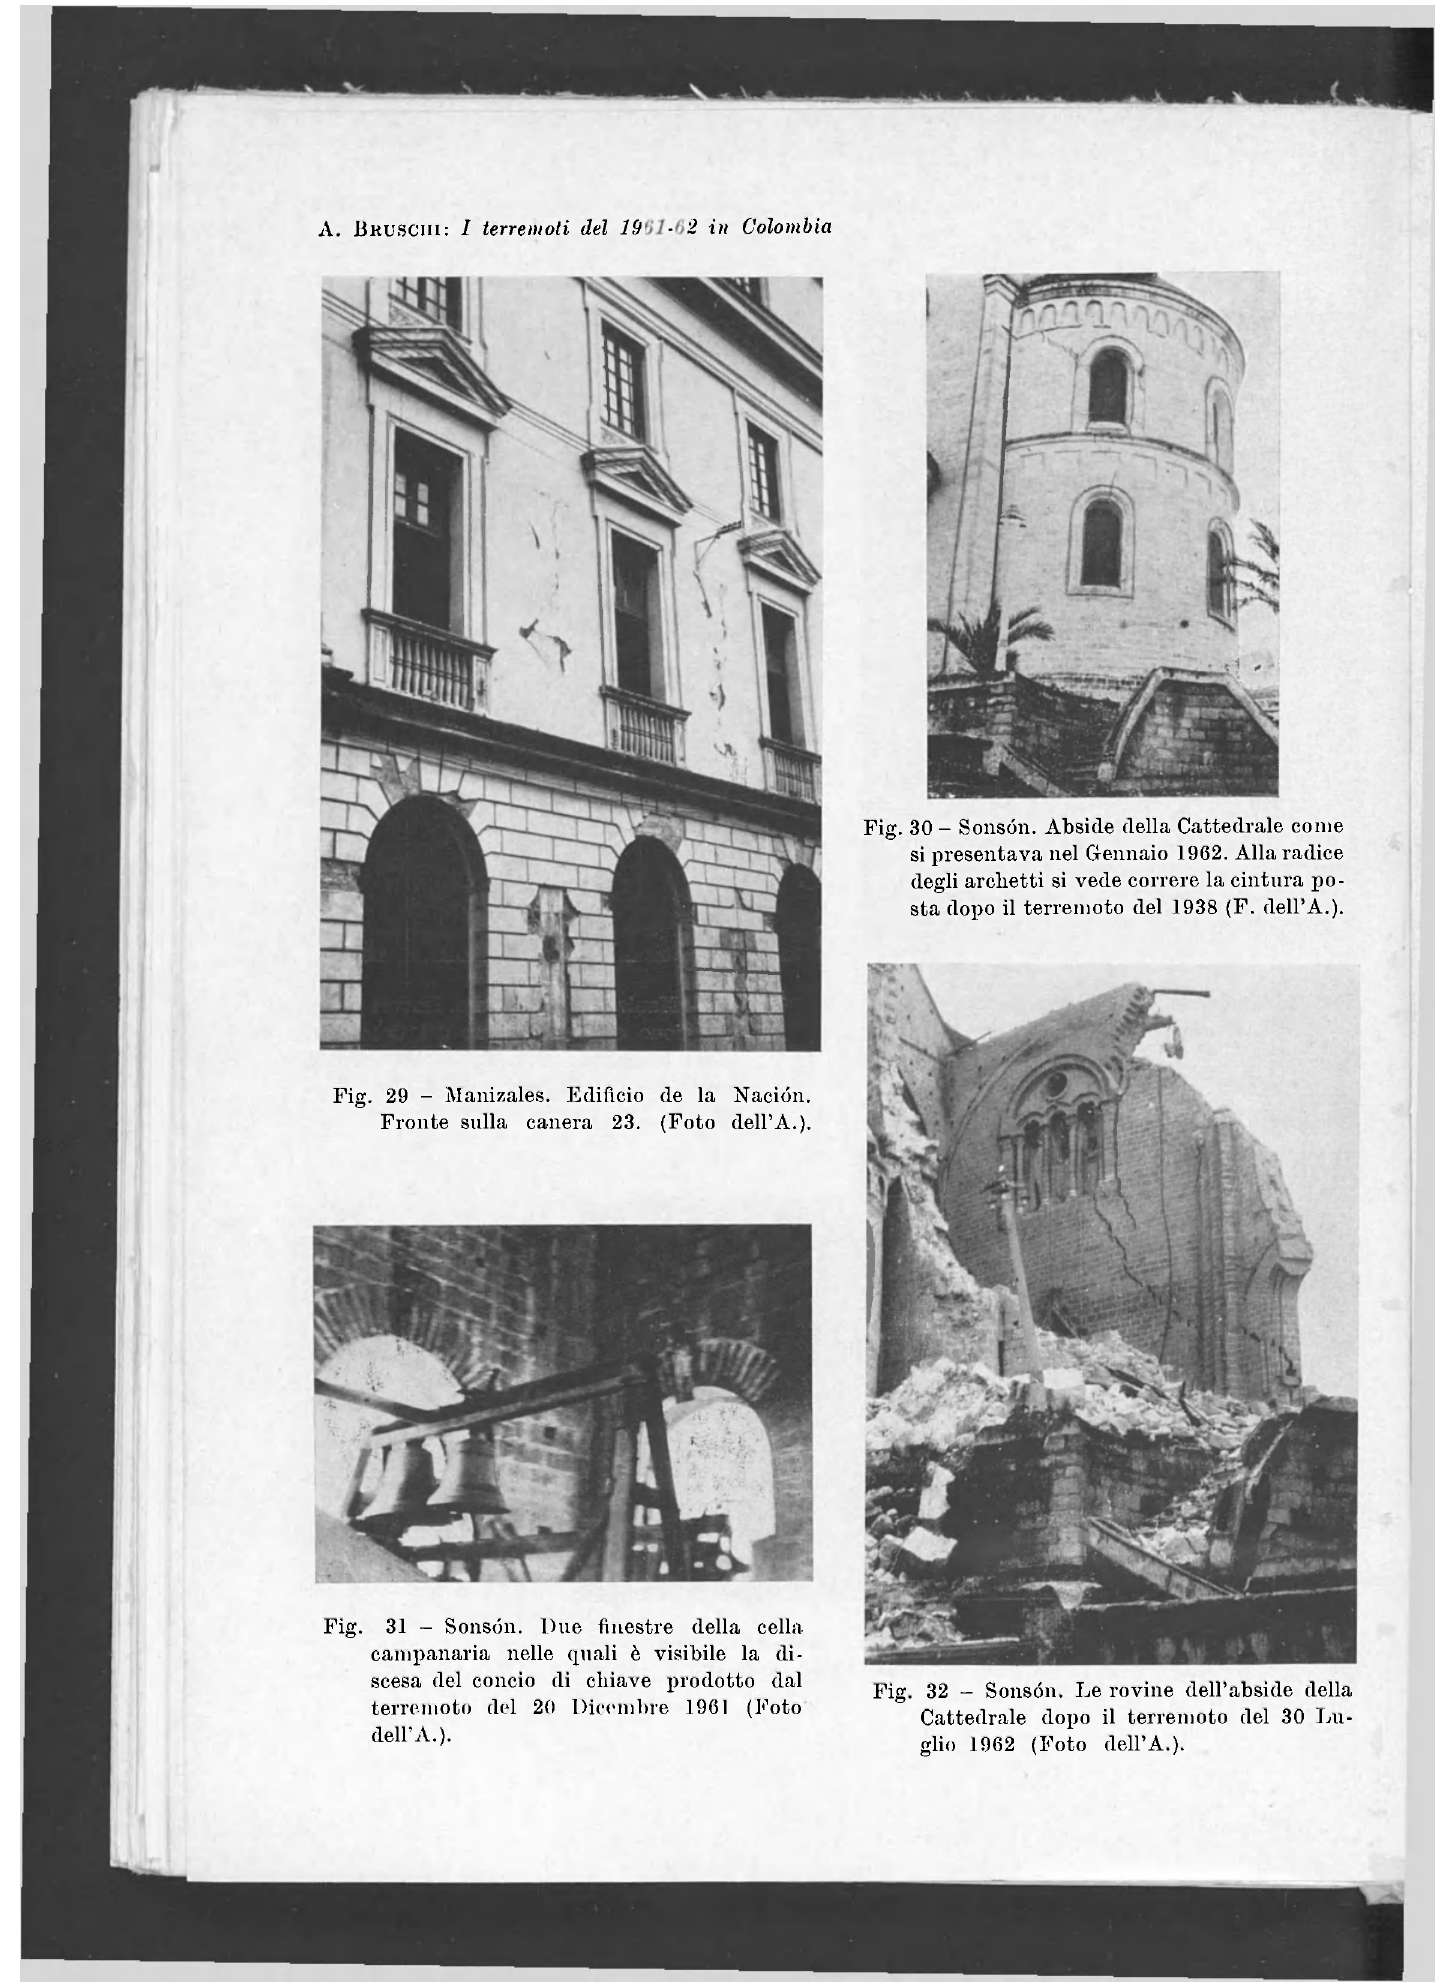
Fig. 32 - Sonsón. Le rovine dell'abside della Cattedrale dopo il terremoto del 30 Lu- glio 1962 (Foto